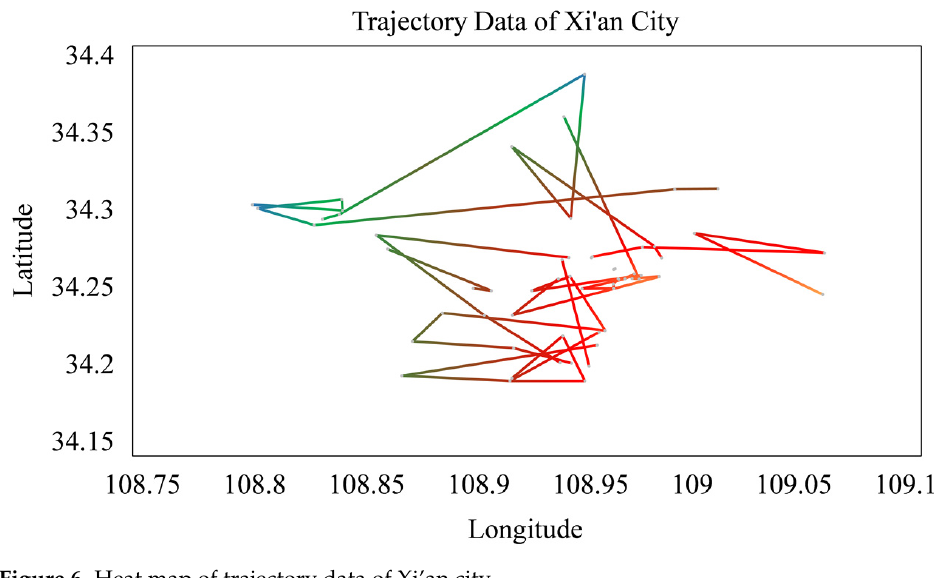
Figure 6. Heat map of trajectory data of Xi’an city.